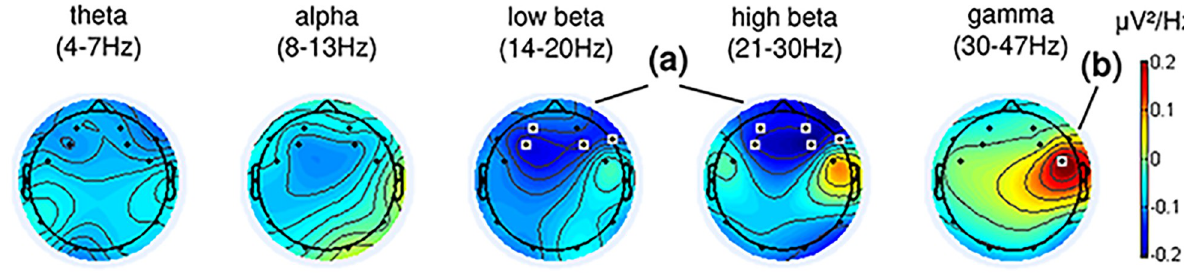
Fig 7. Brain activity modulations during online application in task ! happy averaged across participants P01, P04, and P05. Music feedback modulations toward the happy state were accompanied by significant power decrease in beta band over frontal areas (a), as well as an increase in gamma power over the right hemisphere (b). The highlighted channels indicate Bonferroni-corrected statistically significant modulations comparing action and resting periods (action minus rest), ( p < 0.05).